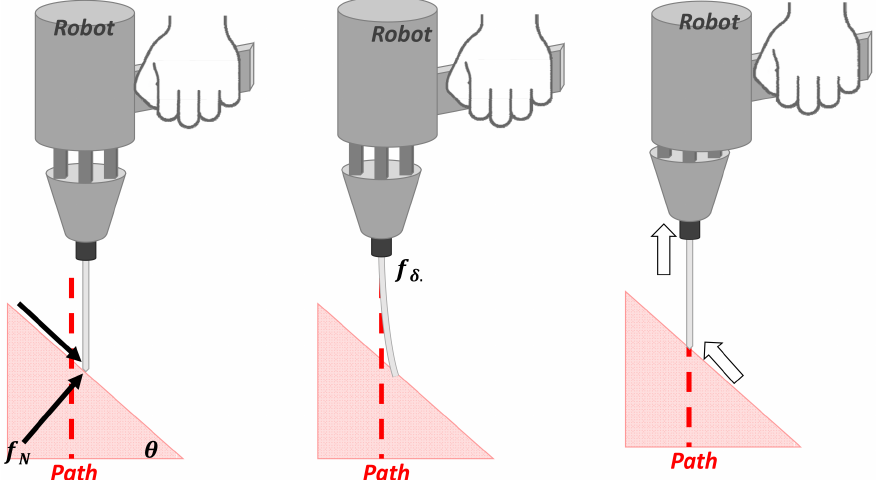
Figure 3. Deviation of the entry point caused by tool deflection when the handheld robot performs alignment correction for hand